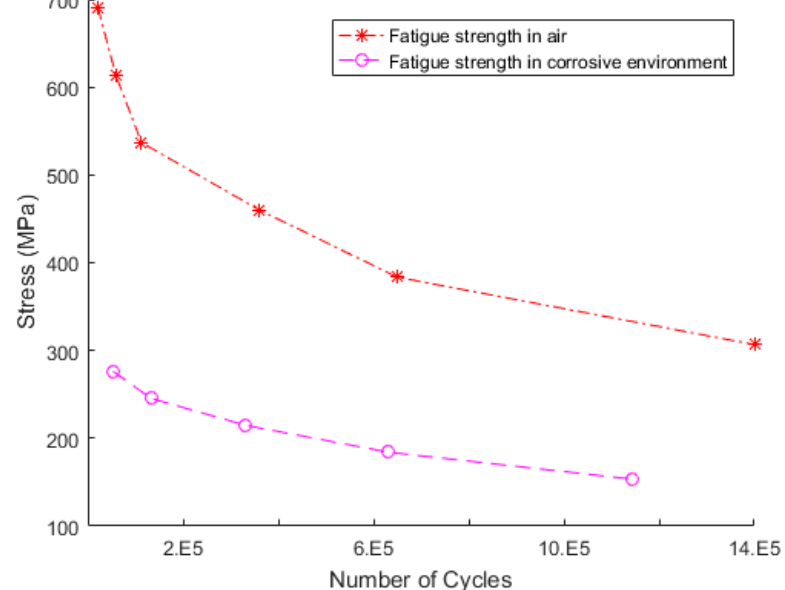
Figure 3. Fatigue strength in the air and in a corrosive environment.